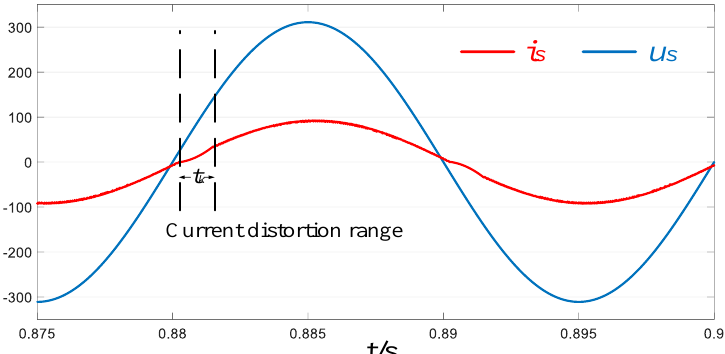
Figure 18. Simulation waveforms of grid voltage and input current when i s lags u s by 5°.